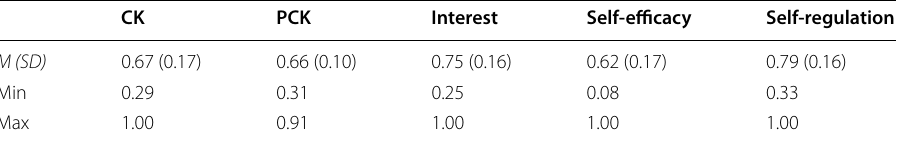
Scales from 0, theoretical minimum, to 1, theoretical